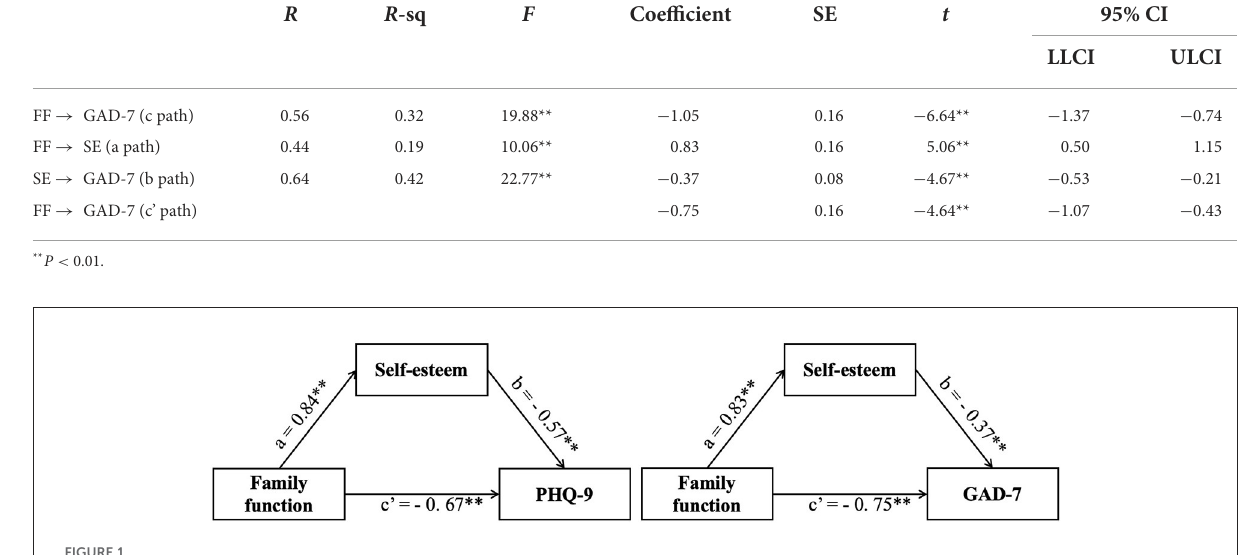
FIGURE1 Mediating role of self-esteem on the relationships between family function and mental health